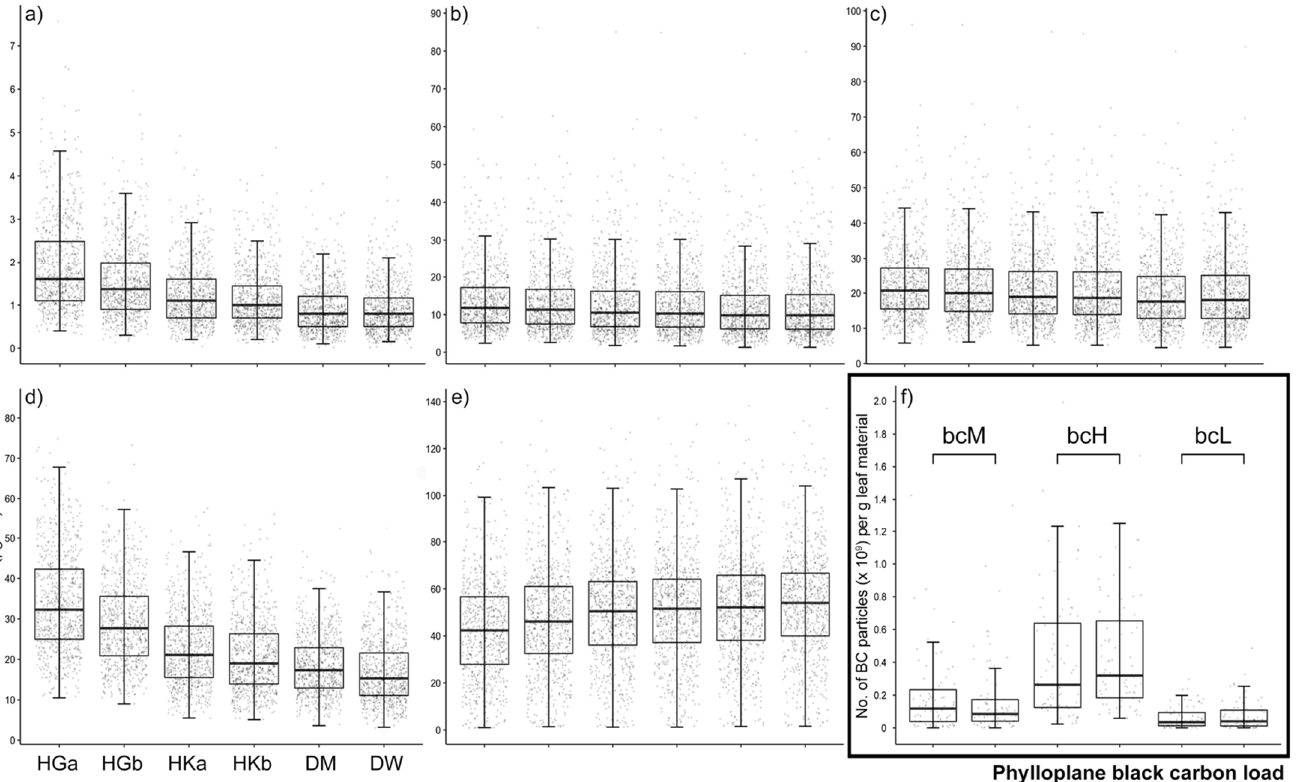
Figure 1. Ambient air pollution parameters and phylloplane black carbon load. Ambient BC ( a ), PM 2.5 ( b ), PM 10 ( c ), nitrogen dioxide ( d ), and ozone ( e ) concentrations were monitored daily from 1 August 2017 until 31 August 2019 ( n = 761) at six sampling sites (HGa, HGb, HKa, HKb, DM, and DW) harboring populations of H. helix plants. Phylloplane BC load ( f ) was assessed during each sampling round ( n = 480). Box plots span the interquartile range (25th to 75th percentile), lines within boxes denote the median, and whiskers extend to 1.5 times the interquartile range. Low (bcL), medium (bcM), and high (bcH) phylloplane BC load. Table 1. Ambient air pollution parameters. Phylloplane black carbon (BC) load ( n = 480) and ambient air BC, PM 2.5 , PM 10d , nitrogen dioxide (NO 2 ), and ozone (O 3 ) concentrations ( n = 761) are given as mean values ± standard deviation (SD) for the six sampling sites. Low (bcL), medium (bcM), and high (bcH) phylloplane BC load. u Significantly different ( p < 0.05) from HGa, v from HGb, w from HKa, x from HKb, y from DM, and z from DW. * No. of BC particles ( × 10 8 ) per g of leaf material. Sampling